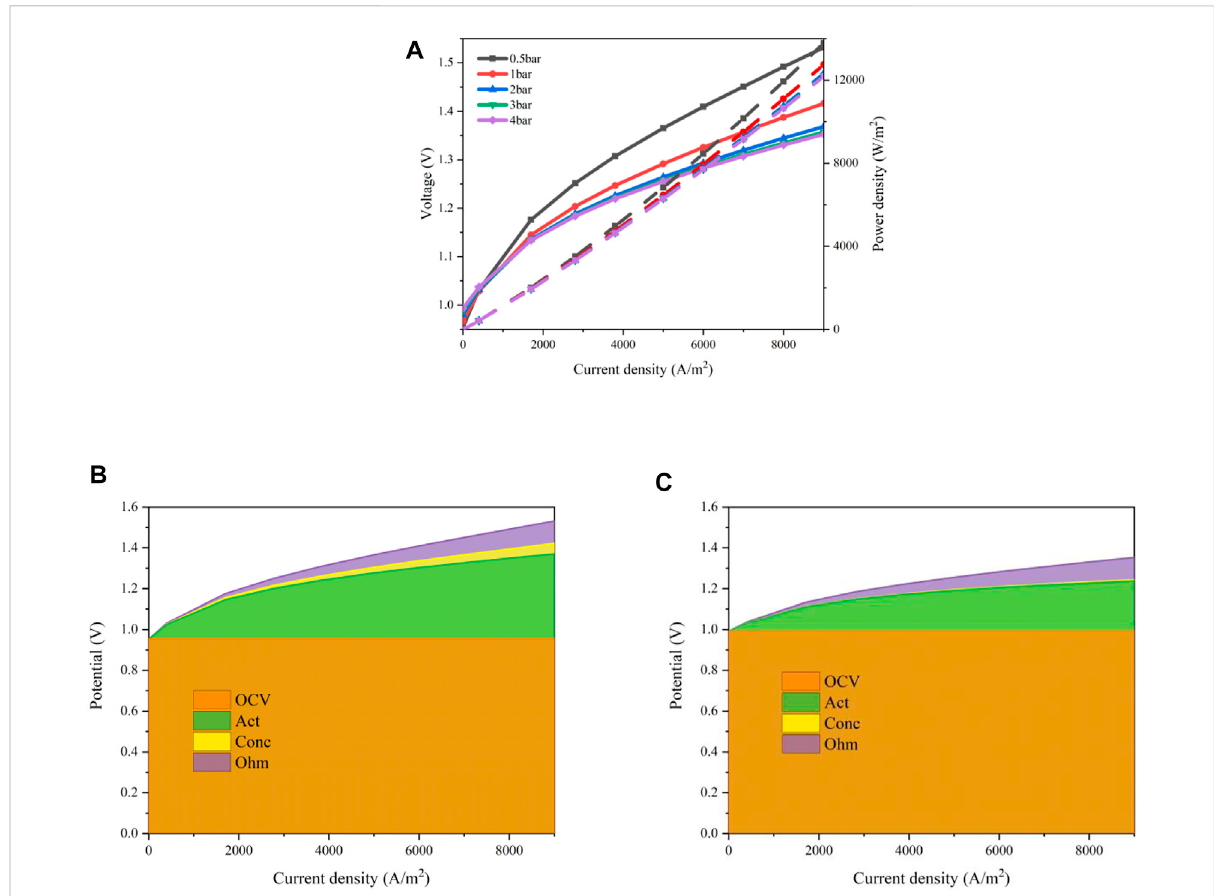
FIGURE 9 Performances of the designed MS-SOEC under various operating pressures: (A) polarization curves; (B) overpotential losses with an operating pressure of 0.5 bar; (C) overpotential losses with an operating pressure of 4 bar.